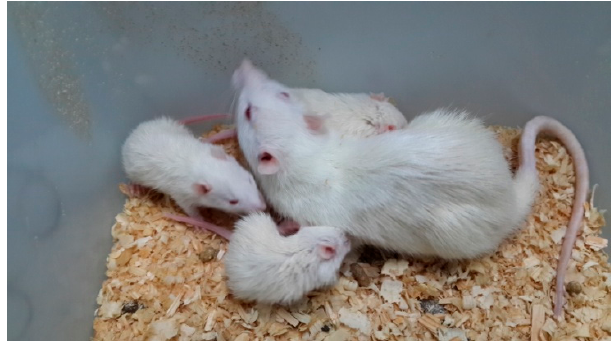
Figure 7. The gestational diabetes mellitus (GDM) offspring at weaning.